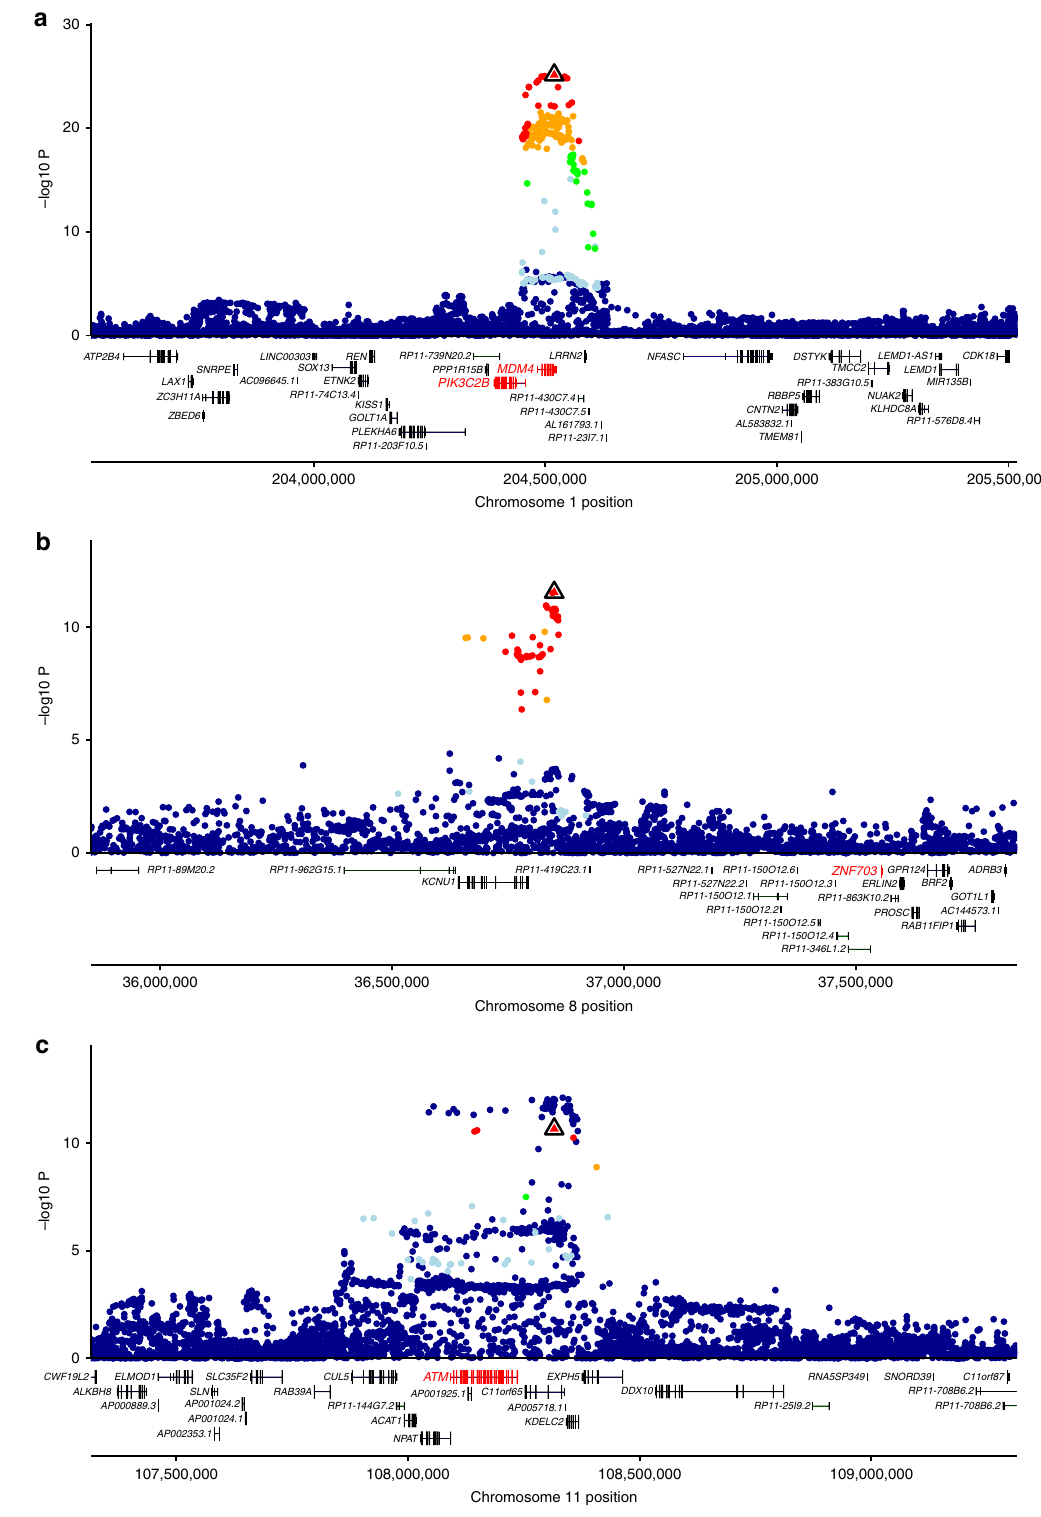
Fig. 4 Examples of previously unreported target gene predictions at known ER- negative breast cancer risk loci. Variants are represented by points colored according to the LD with the sentinel risk variant (red: ≥ 0.8, orange: 0.6 – 0.8, green: 0.4 – 0.6, light blue: 0.2 – 0.4, and dark blue: <0.2). Sentinel risk variants (triangles) were identi fi ed based on joint association analysis 9 . Figure shows on the y -axis the evidence for ER-negative breast cancer association ( − log 10 of the P -value in the original published GWAS results 3 , obtained in that study using an inverse-variance meta-analysis), and on the x -axis chromosomal position. Gene structures from GENCODE v19 gene annotations are shown and the predicted target genes shown in red. The sentinel risk variants are in LD with sentinel eQTL for MDM4 and PIK3C2B ( a ), ZNF703 ( b ), and ATM ( c ; Supplementary Data 17). Regional association plots for the remaining 14 previously unreported target gene predictions are provided in Supplementary Figure